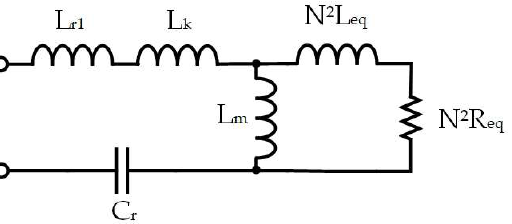
Figure 10. Modified equivalent model of a heating coil and workpiece combined with a transformer.